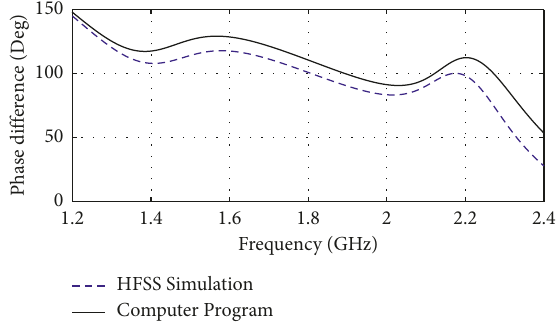
Figure 11: Phase difference between through and coupled ports of 3 dB ATRD